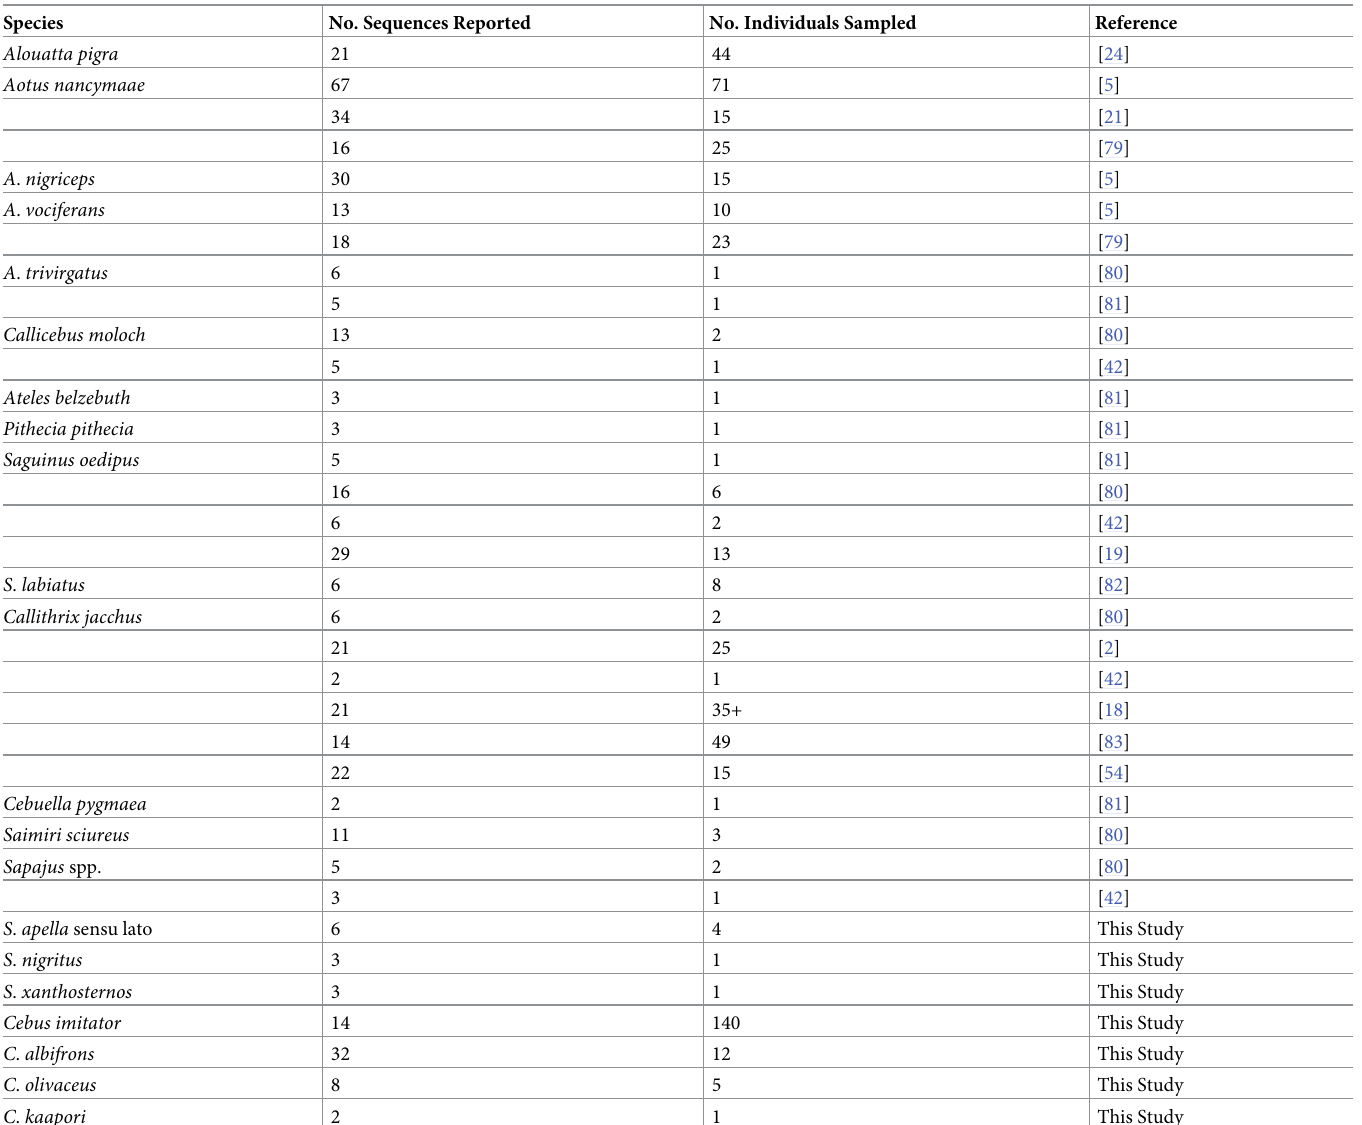
Table 6. Reported DRB exon 2 variation in New World